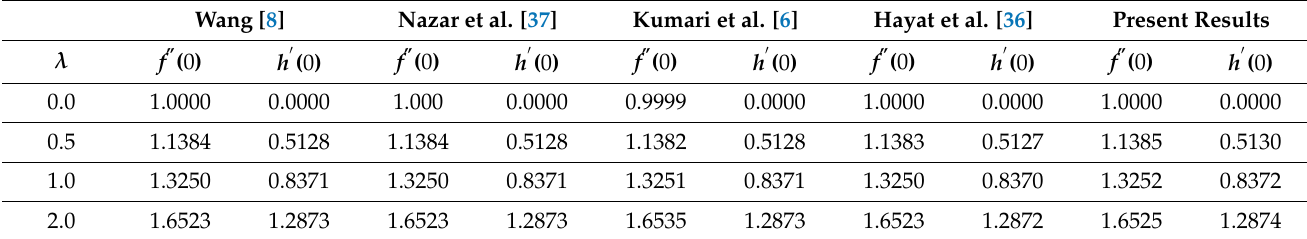
Table 3. Comparison of absolute values of f (cid:48)(cid:48) ( 0 ) and h (cid:48) ( 0 ) . Wang [8]